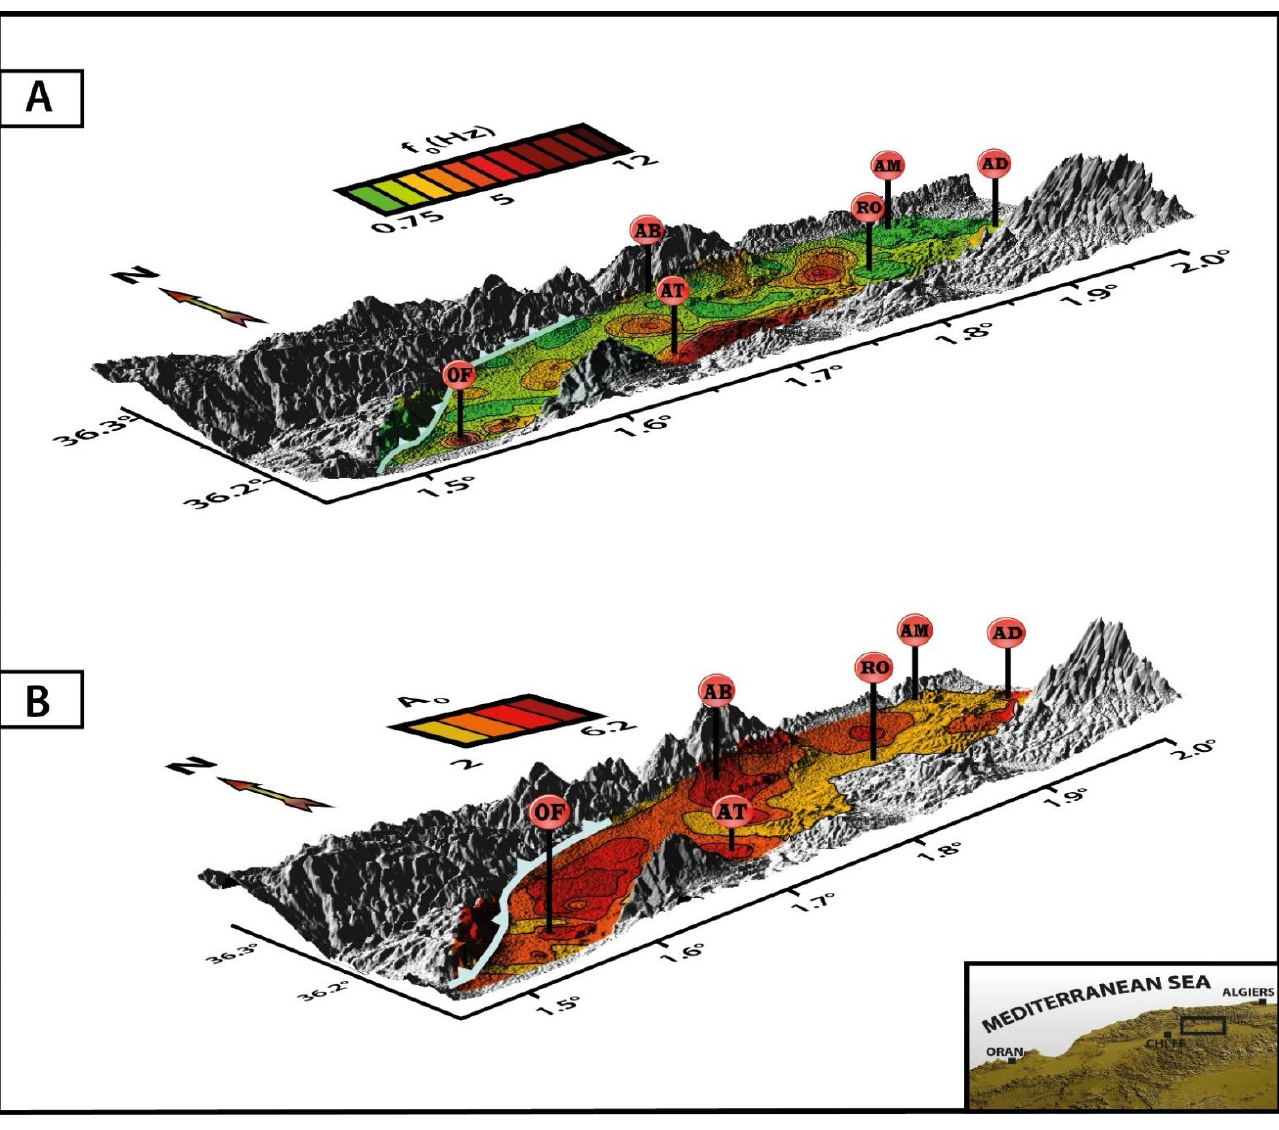
Figure 9. ( A ) Fundamental frequencies obtained from the HVSR analysis. ( B ) Amplitudes of the HVSR fundamental frequency peaks. Red circles represent the cities. The blue line represents the surface trace of the El-Asnam fault. OF: Oued- Fodda. AB: El-Abadia. AT: El-Attaf. RO: Rouina. AM: El-Amra. AD: Ain-Defla.